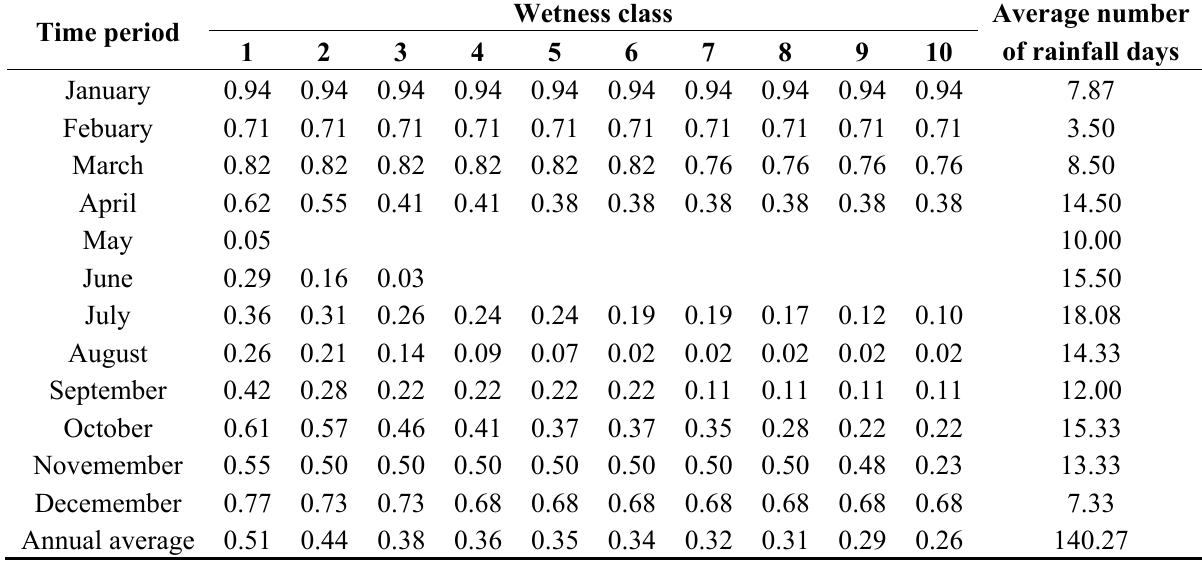
Table 5. Probability of saturation for each wetness class and month as predicted with the hydrologic assessment tool in Salmon Creek. Each wetness class represents 10% of the watershed area. Wetness class 1 indicates areas most prone to saturation; wetness class 10 indicates areas least prone to